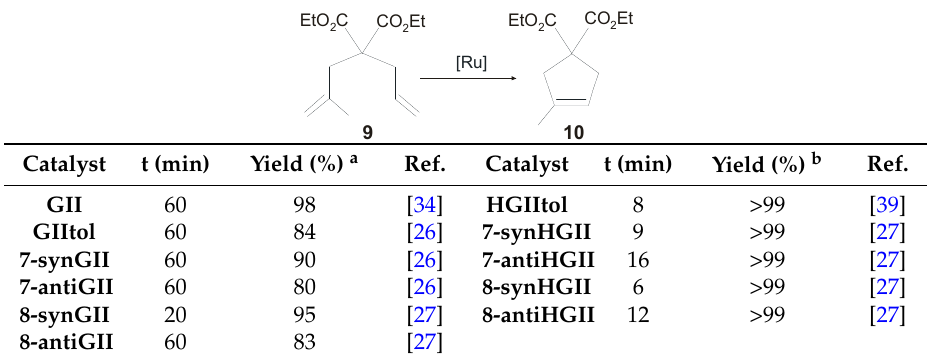
Table 2. RCM of diethyl allylmethallylmalonate 9 .